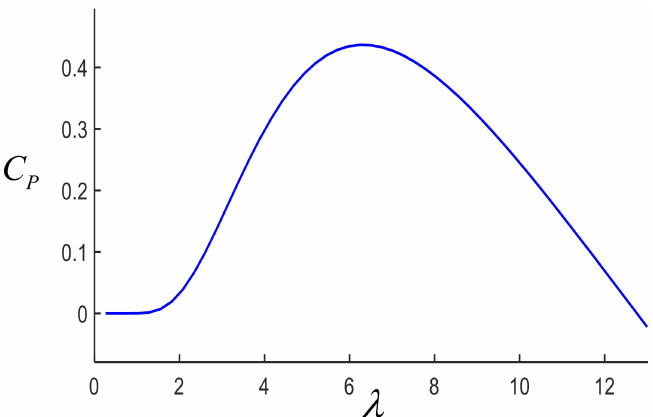
Figure 2. The curve of coefficient ( C P ) and tip speed ratio ( λ )